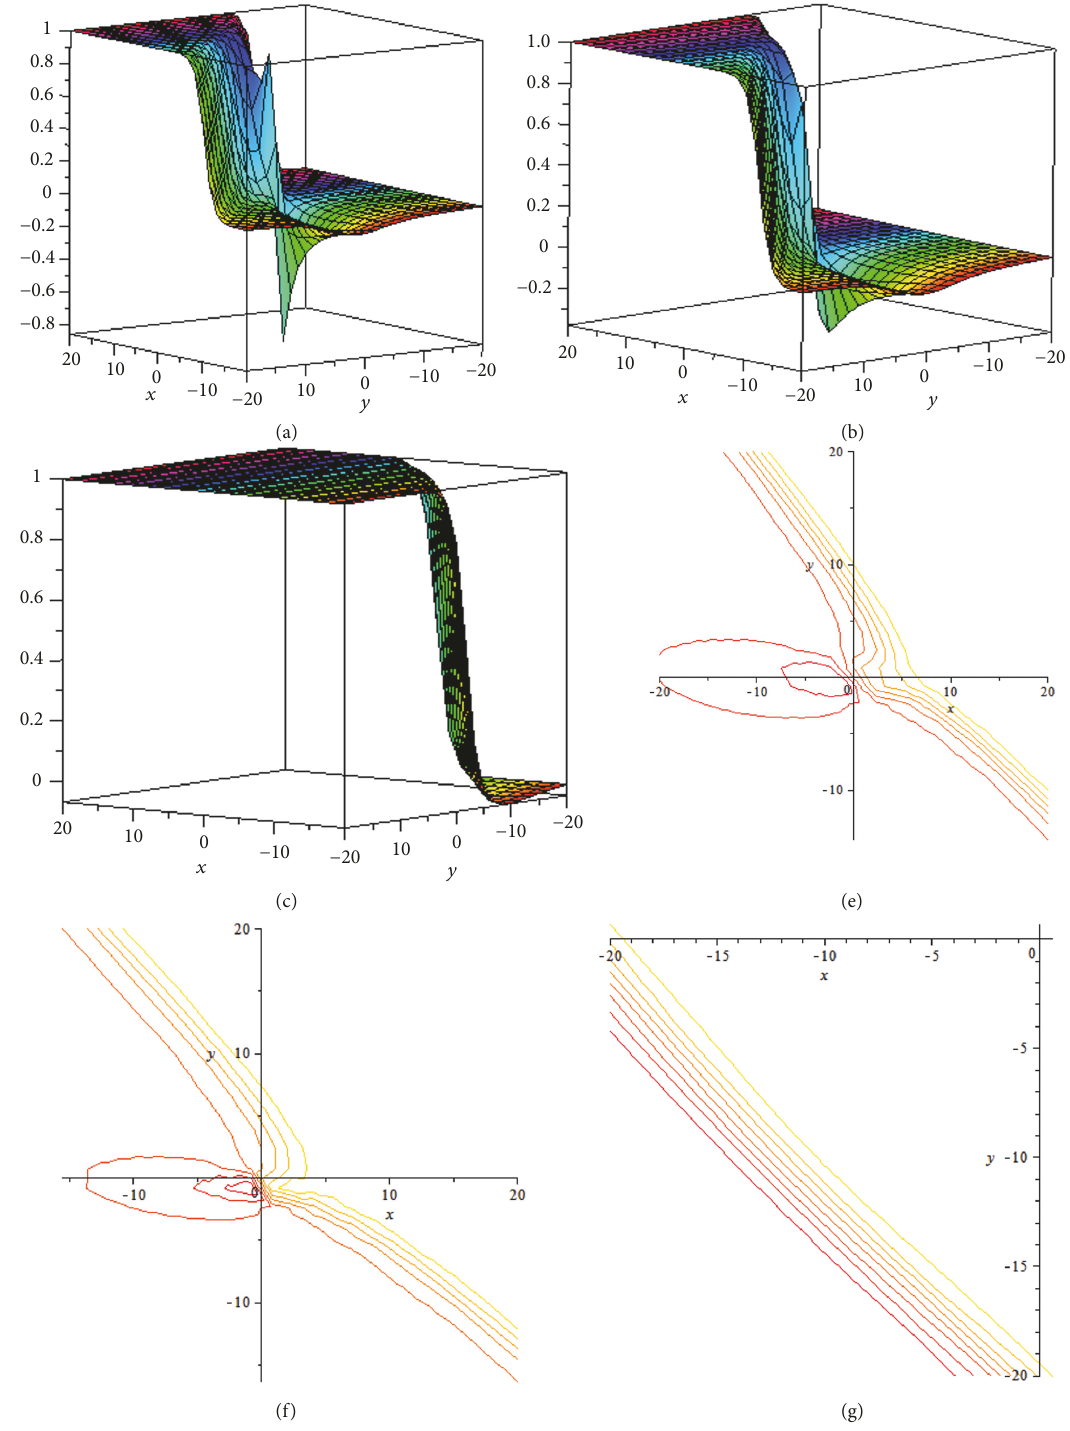
Figure 2: Proportion scene of the solution equation (10) with (13) and (11) for the values of arbitrary constants is 𝛼 1 = 1,𝛼 4 = 0,𝛼 6 = 3,𝛼 5 = = 0 , and 𝑘 = 𝑘 = 𝑘 = 1. (a-c) represent 3D plots for (10) at 𝑡 = 0,2 , and 30, 𝑧 = 0 , respectively. (e-g) Consistent contour plot of (a, b, 1,𝛼 10 1 2 5 c),